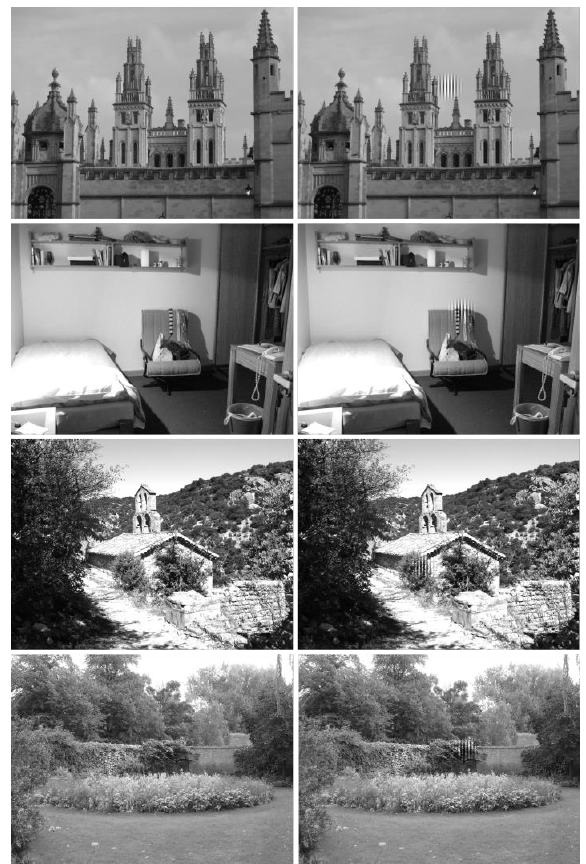
Figure 1: Examples of scenes without (left column) and with the distractor (right column); distractors always appeared 4° from the scene